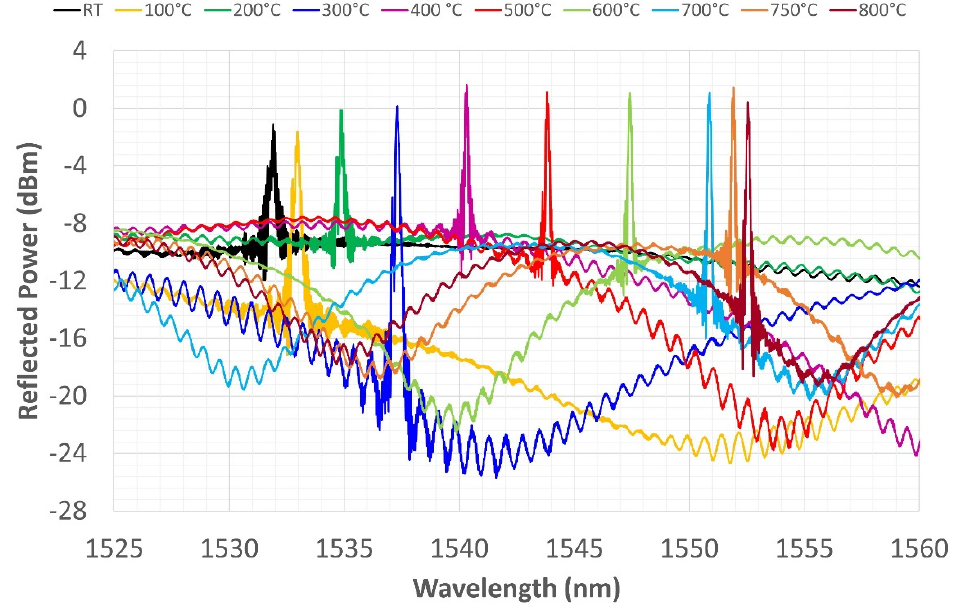
Figure 12. Third thermal cycle—grating reflected spectrum change during heating from RT to 800 °C.